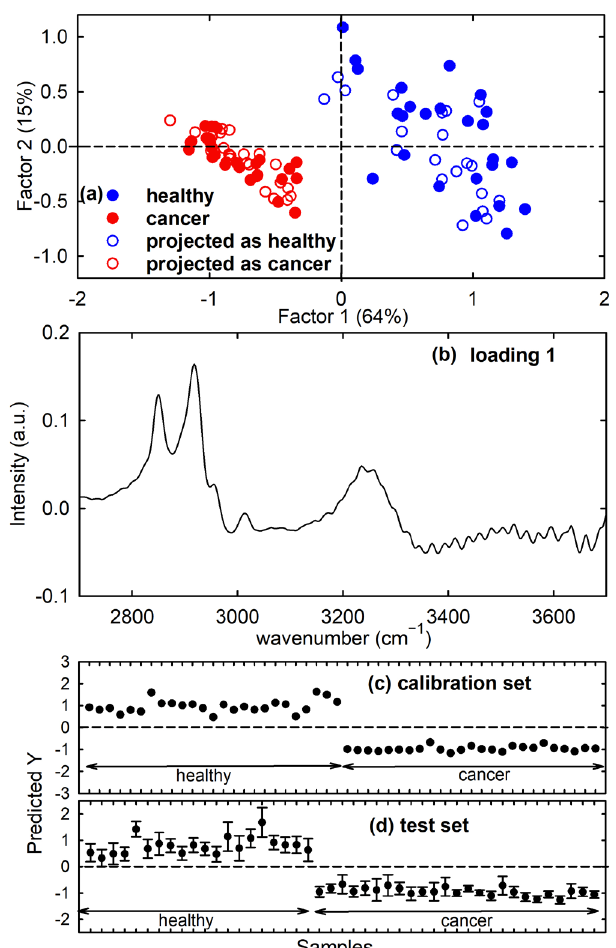
Figure 4. Score plot (factor 2 vs. factor 1) of the developed PLS-DA model showing the calibration (filled circles) and projected test set (hollow circles) samples for the healthy FHC cell (blue circles) and cancerous CaCo-2 cell (red circles) spectra in (a). The root mean square error for cross-validation (RMSECV) with three factors is 0.30. Loading 1 plot for the PLS model in (b). Predicted Y values with respect to the reference values (1: healthy FHC cells; −1: cancer CaCo-2 cells) after PLS regression for the spectra of the calibration set and predicted Y values, with corresponding deviations from the PLS-DA model for the spectra of the test set, are reported in (c) and (d), respectively, with black dots.